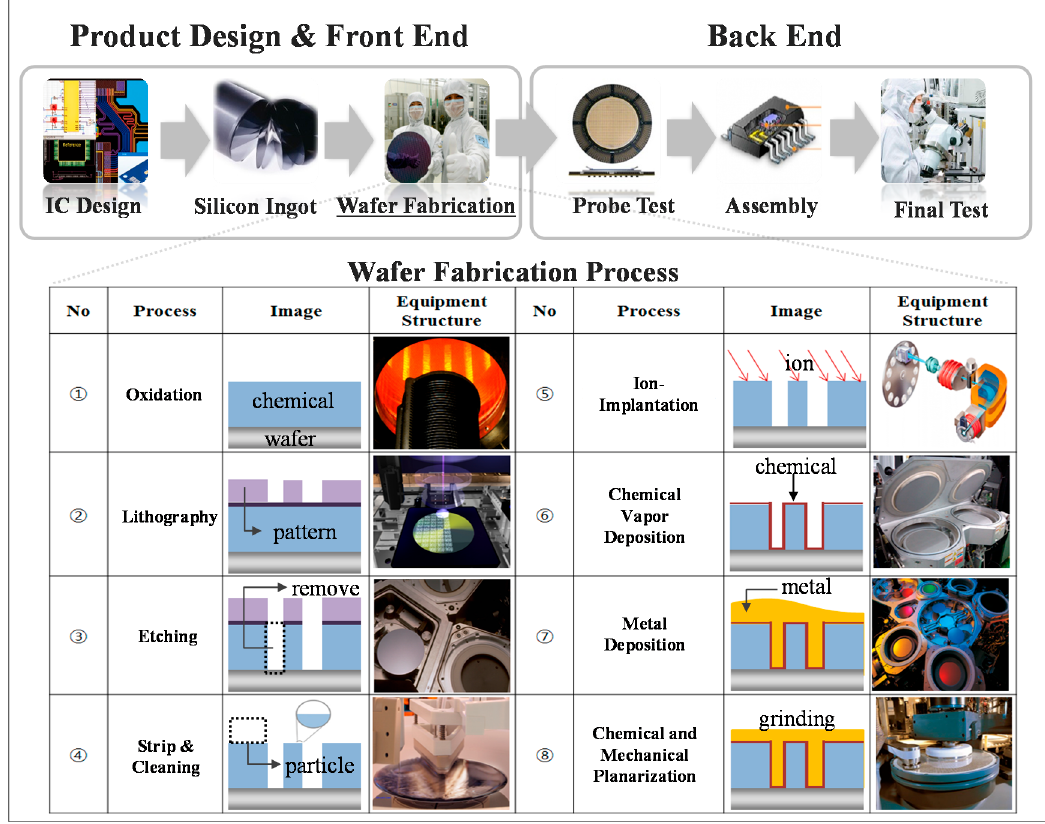
Figure 1. The semiconductor manufacturing process. IC, Integrated Circuit.